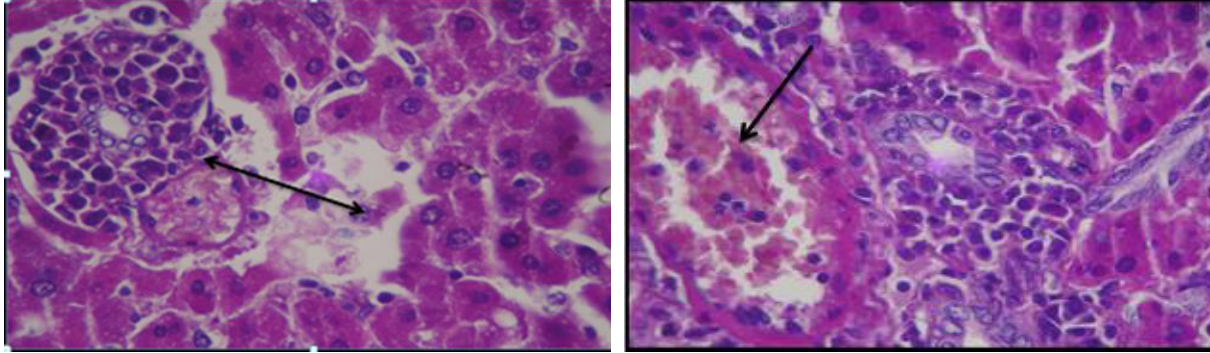
Figure,3 : Photomicrographs showing histology of liver tissue from group T1 showed MNCs